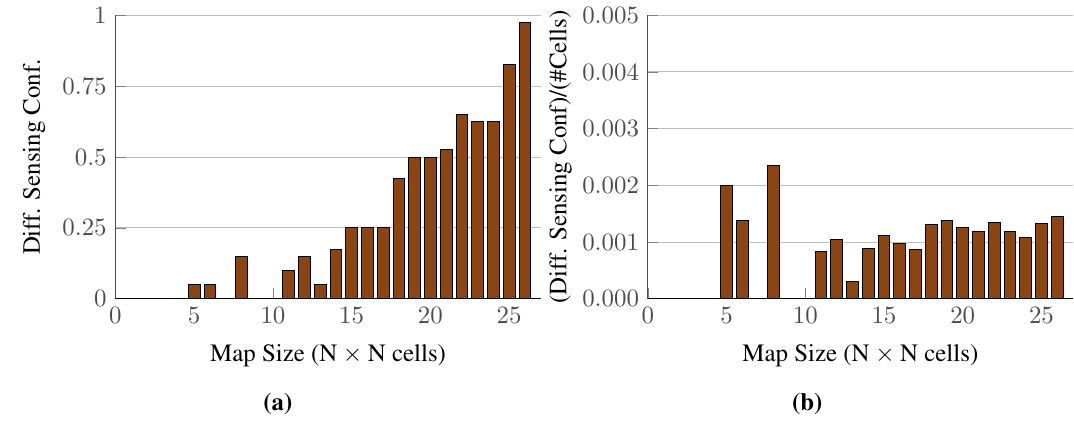
Figure 12. The solution quality gap between conv -SPP and combinatorial optimization. ( a ) shows the average difference for all possible combinations of the sensing parameters r = { 15 , 30 } and φ = { π, π/ 2 } ; ( b ) shows the average difference divided by the number of cells in the